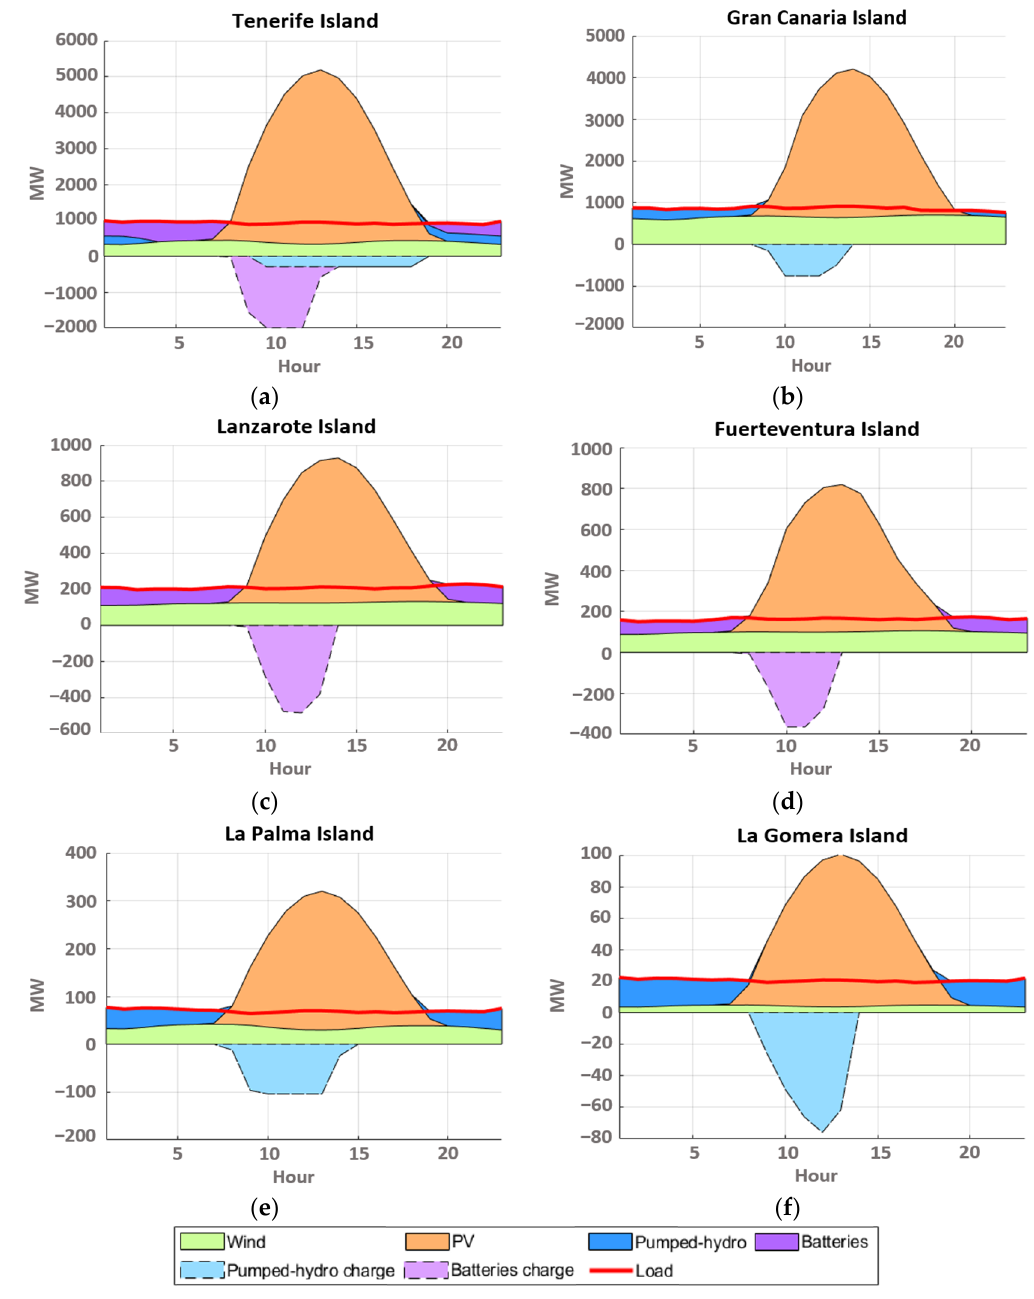
Figure 15. Hourly performance of the generation and storage systems on a typical summer day. ( a